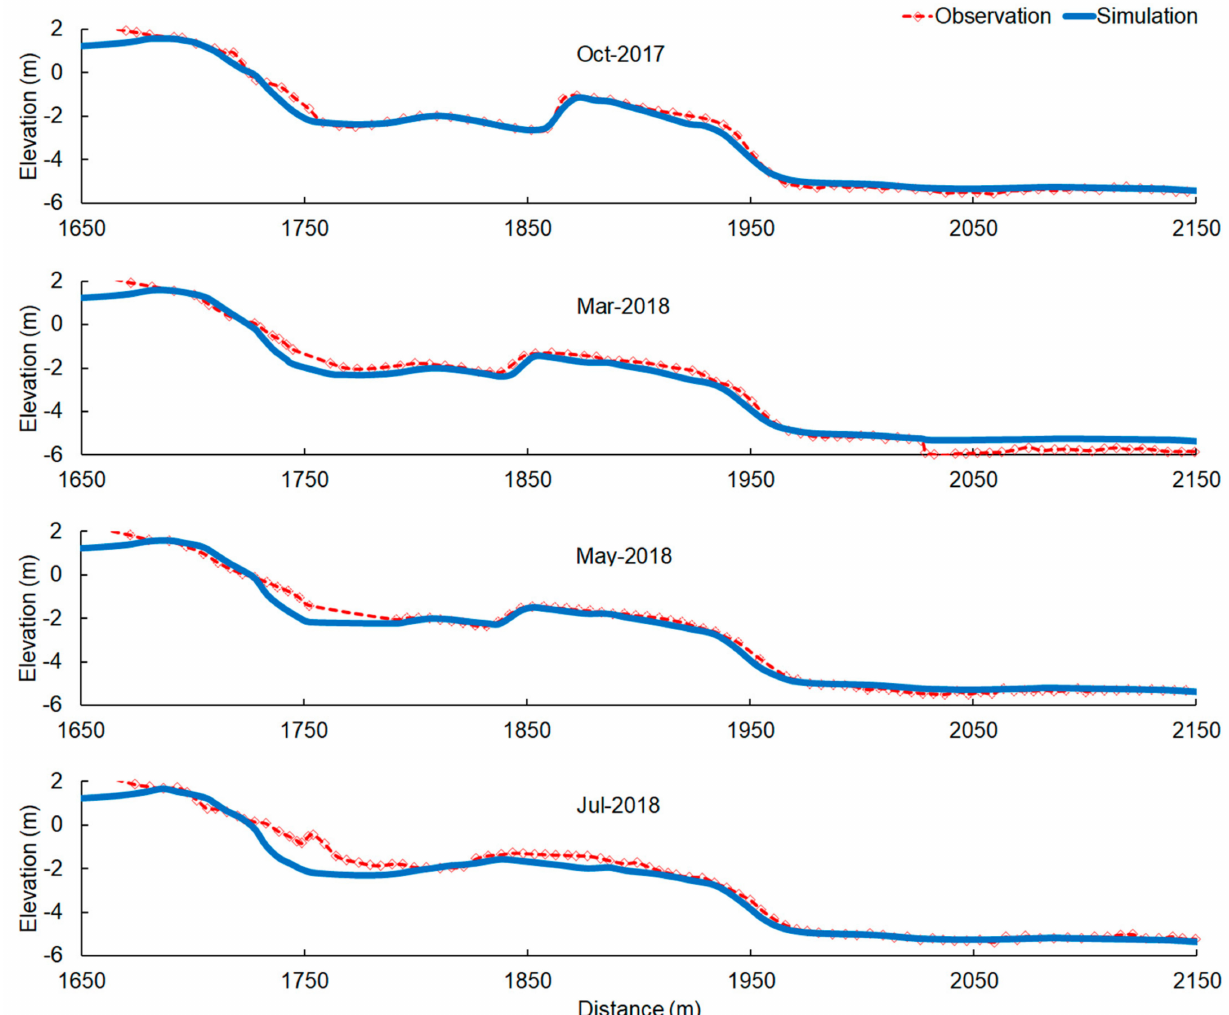
Figure 4. Time series of the simulated and observed significant wave height (H s ) and direction during a week-long period of April 2017 at Qinhuangdao wave gauge W1.